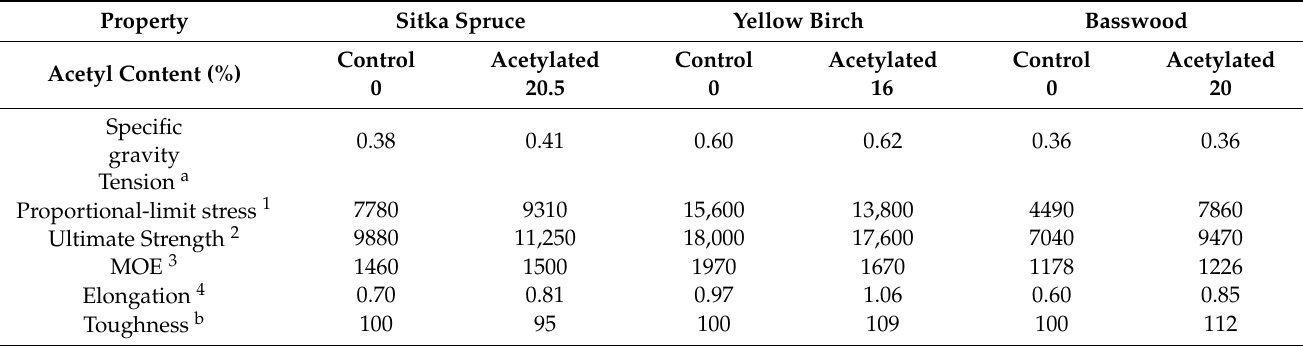
Tables 6 and 7 show some physical properties of control and acetylated yellow birch